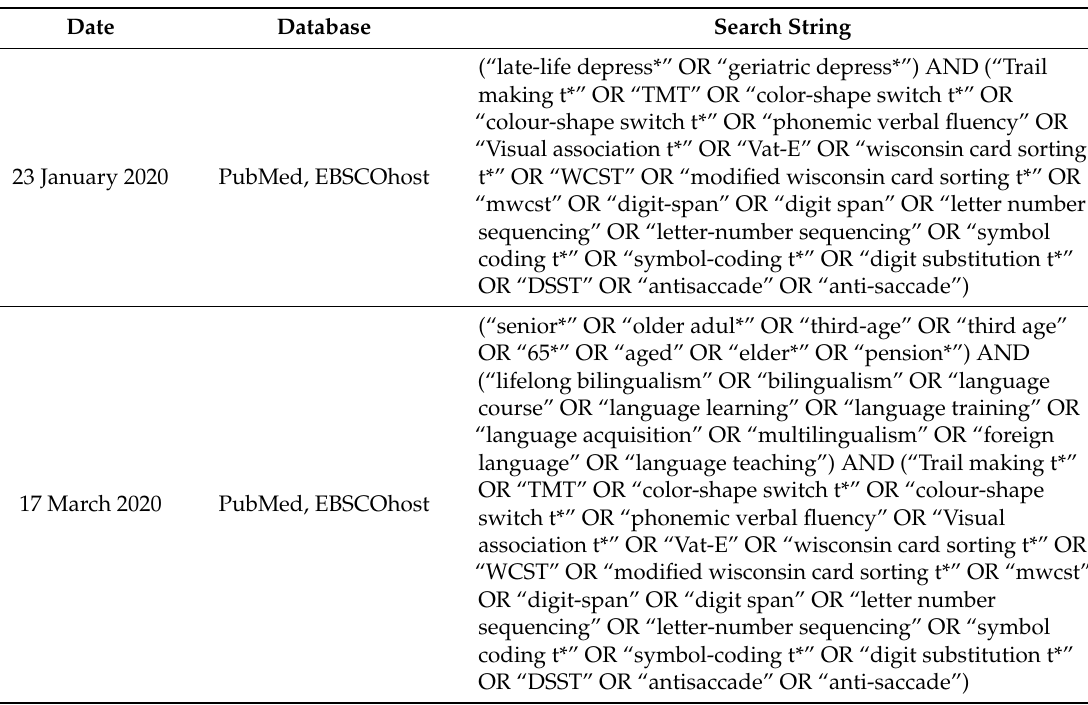
Table 1. Complete search strategy for the present